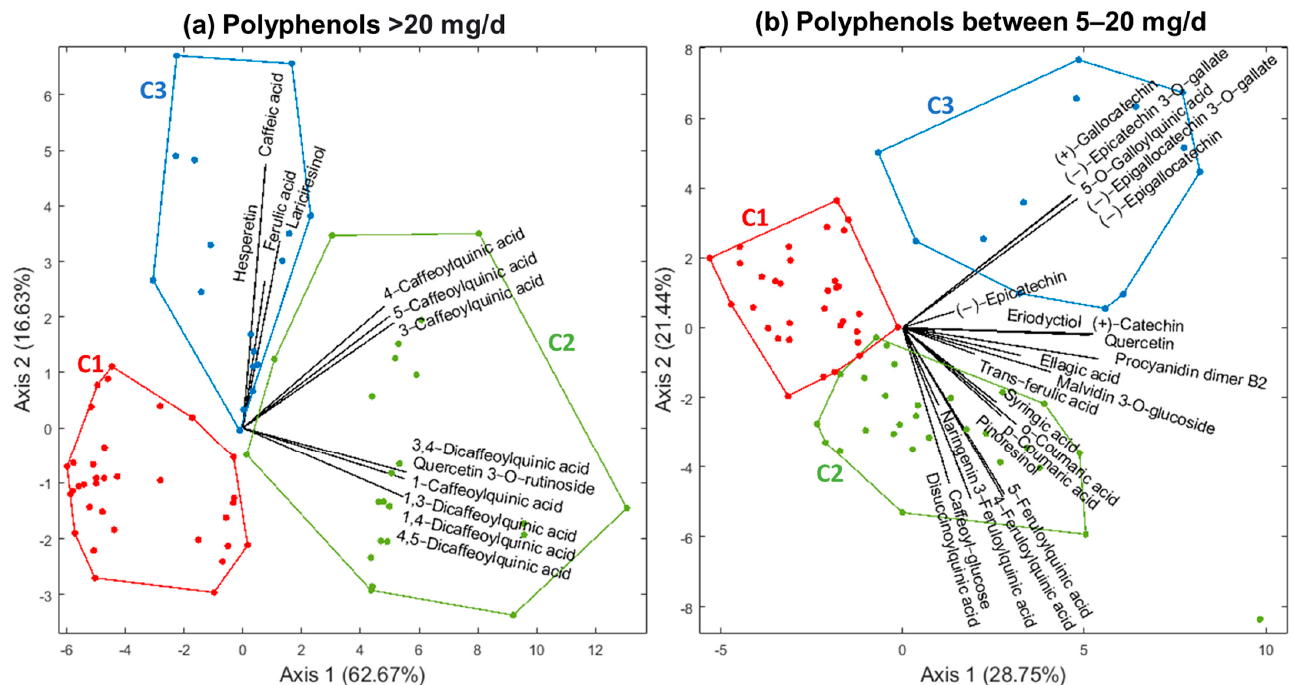
Figure 3. HJ-Biplot representation (axis 1–2) for clusters of polyphenols consumed above 20 mg/d ( a ) and between 5 and 20 mg/d ( b ) by Argentinian postpartum women.